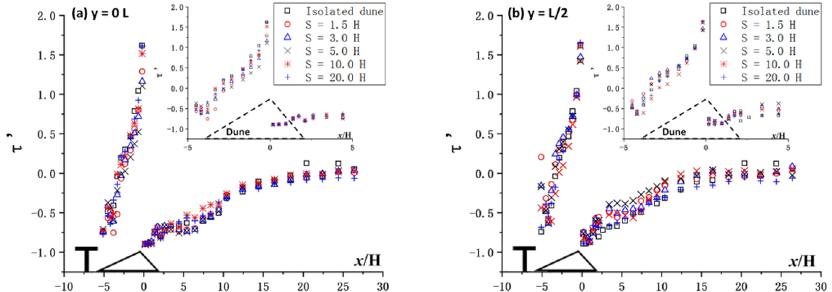
Figure 6. Normalized shear stress '  with normalized distance x/H. H is the height of sand dune, L is the distance of piers of bridge, S is the distance between bridge and sand dune and y is the distance between measuring position and the